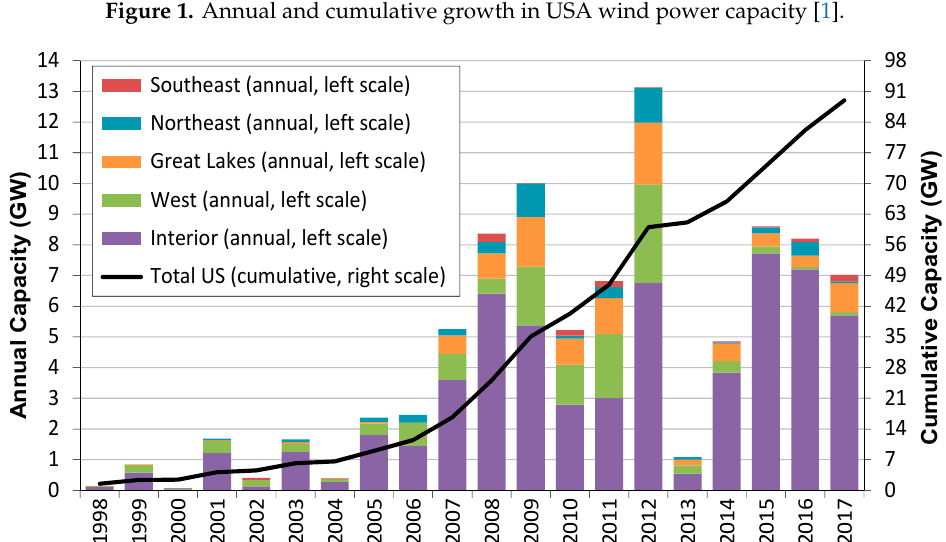
Figure 2. Annual and cumulative growth in USA wind power capacity [2].